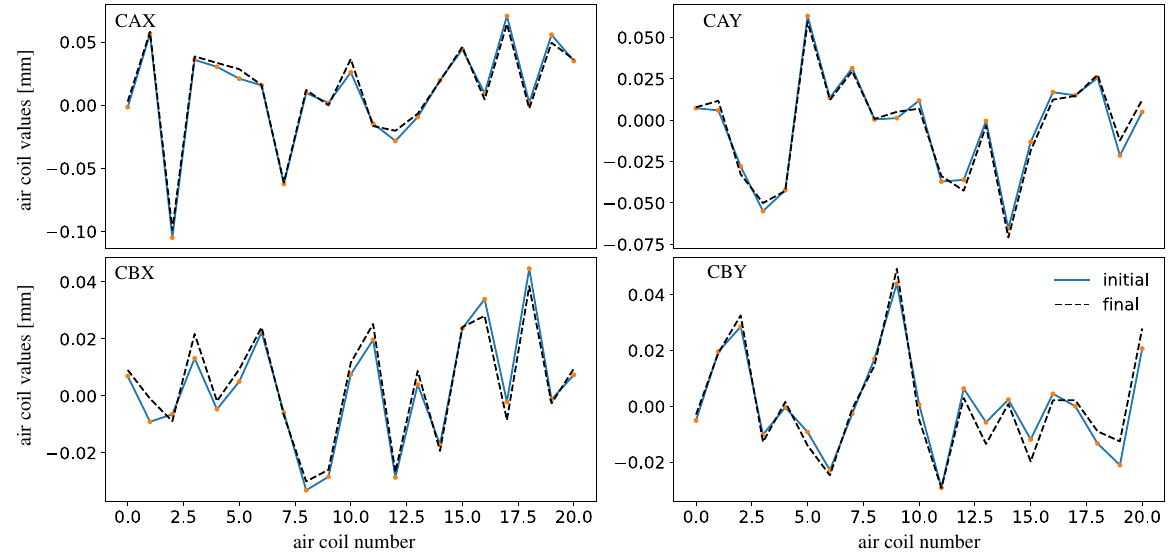
FIG. 8. Initial and final settings of 84 air coils which were tuned to maximize average bunch energy.